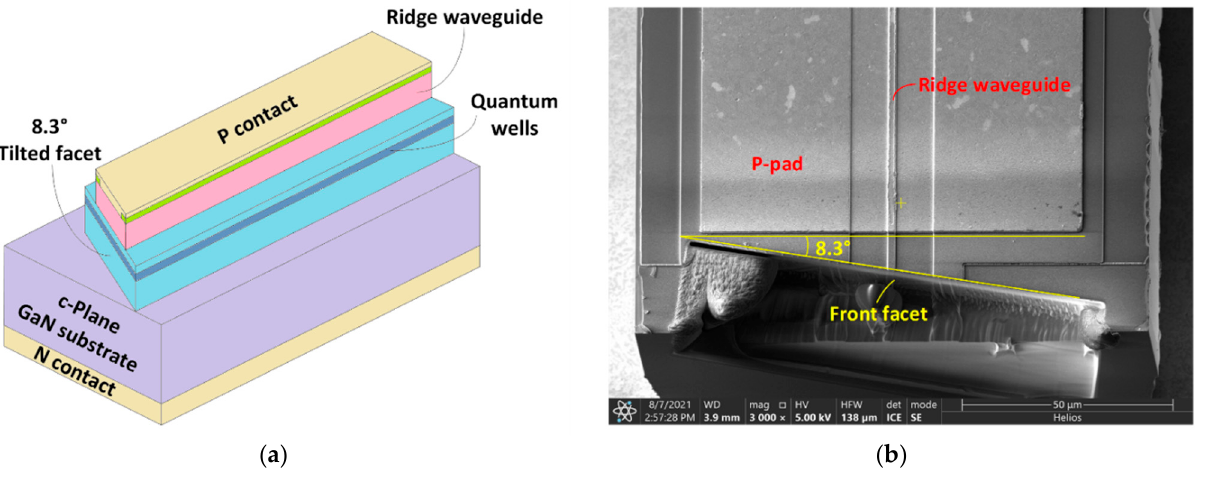
Figure 1. ( a ) Schematic illustration of the superluminescent diode on the GaN substrate; ( b ) the scanning electron microscopy (SEM) image of the fabricated SLD